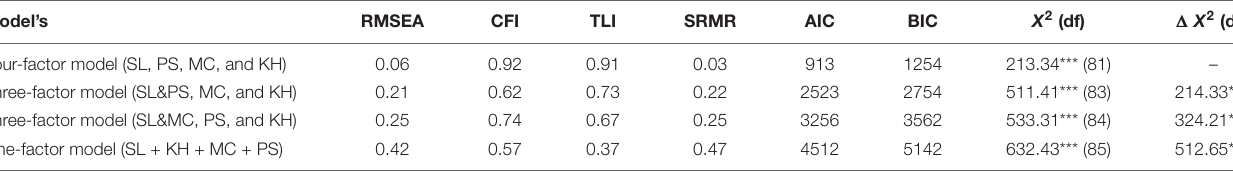
TABLE 4 | Confirmatory factor analyses and construct